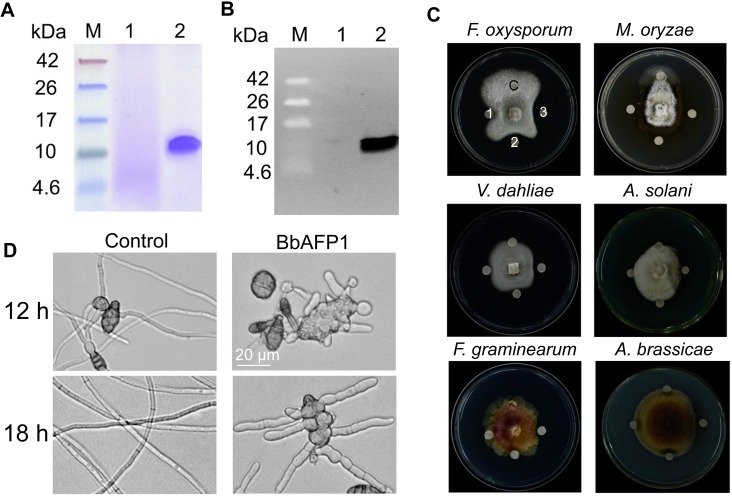
Purification and inhibitory activity of BbAFP1 against filamentous fungi.(A) SDS-PAGE and (B) Western blot analyses of BbAFP1 expressed in P. pastoris. M, prestained low molecular weight markers. Lane 1, supernatant of P. pastoris transformed with pPIC9k (control); Lane 2, BbAFP1 purified from P. pastoris by His-tag affinity chromatography. (C) Effects of BbAFP1 on growth of indicated fungi on PDA plates. Labels on plate are as follows; C = control, 20 mM NaAC (pH 5.4). 1–3 = 0.5, 1.0, 1.5 μg of BbAFP1 spotted onto disks, respectively. The same sequence of samples was used in all plates. (D) Representative images of the effects of BbAFP1 on conidial germination and hyphal growth of A. brassicae. A conidial suspension of A. brassicae (1 × 106 conidia/ml) was inoculated into PDB containing 5.0 μM BbAFP1 and cultured at 26°C for 12–18 h. The amount of BbAFP1 was determined by the Bradford method.